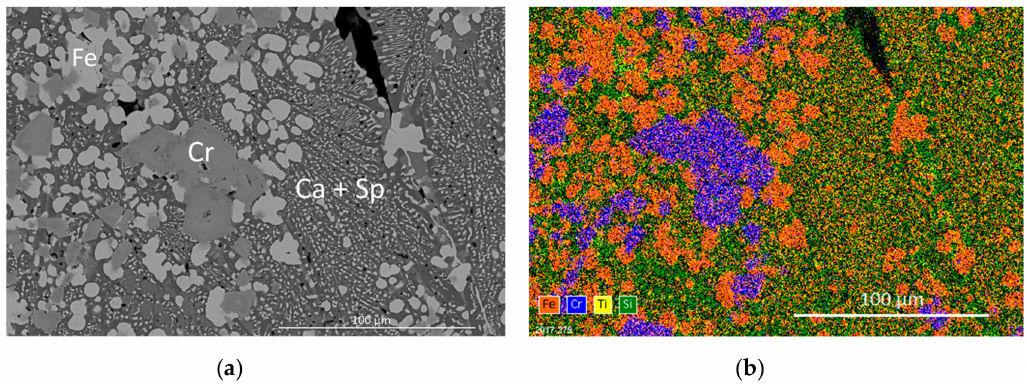
Figure 1. ( a ) SEM-BSE (back scattered electrons) image of CS slags. Ca = Ca(Al)-silicates (larnite, gehlenite) (dark grey), Fe = Fe oxides (wuestite, Fe spinel), Sp = Mg–Al spinel, Cr = Mg chromite. Di ff erent minerals are intergrown at small (10–100 µ m) scale. ( b ) Element distribution as determined by EDX, showing the presence of Cr in selected